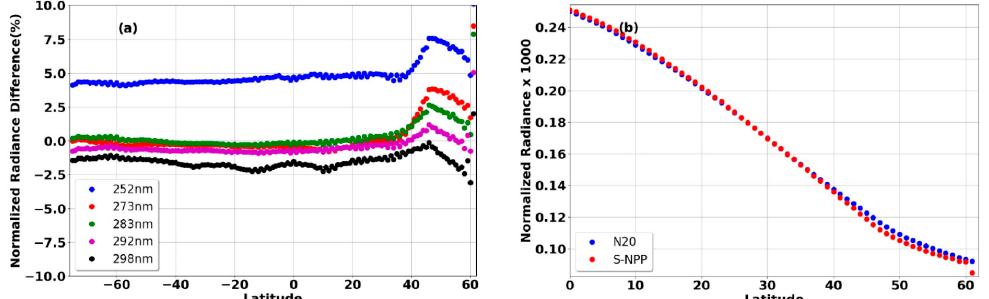
Figure 15. Zonal means of the 32D-AD for SNPP and NOAA-20 OMPS NP NR data at the channels, 252, 273, 283, 288, 292, 298 nm, which are computed at each 10 ° latitude running bin. In the calculations, the data beyond the SZA of 75 ° are removed due to a much smaller sample size. ( a ) Zonal means of 32D-AD over NH between SNPP and NOAA-20 NPs at the channels, 252, 273, 283, 288, 292, 298 nm. ( b ) The zonal mean of NP NR at 273 nm over NH for SNPP and NOAA-20 individually.